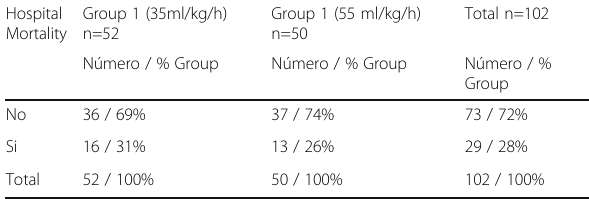
Table 92 (abstract A294). Hospital